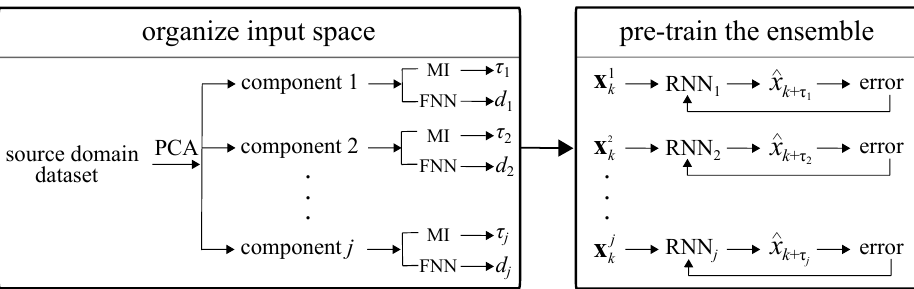
Figure 3. Feature extractors training algorithm.